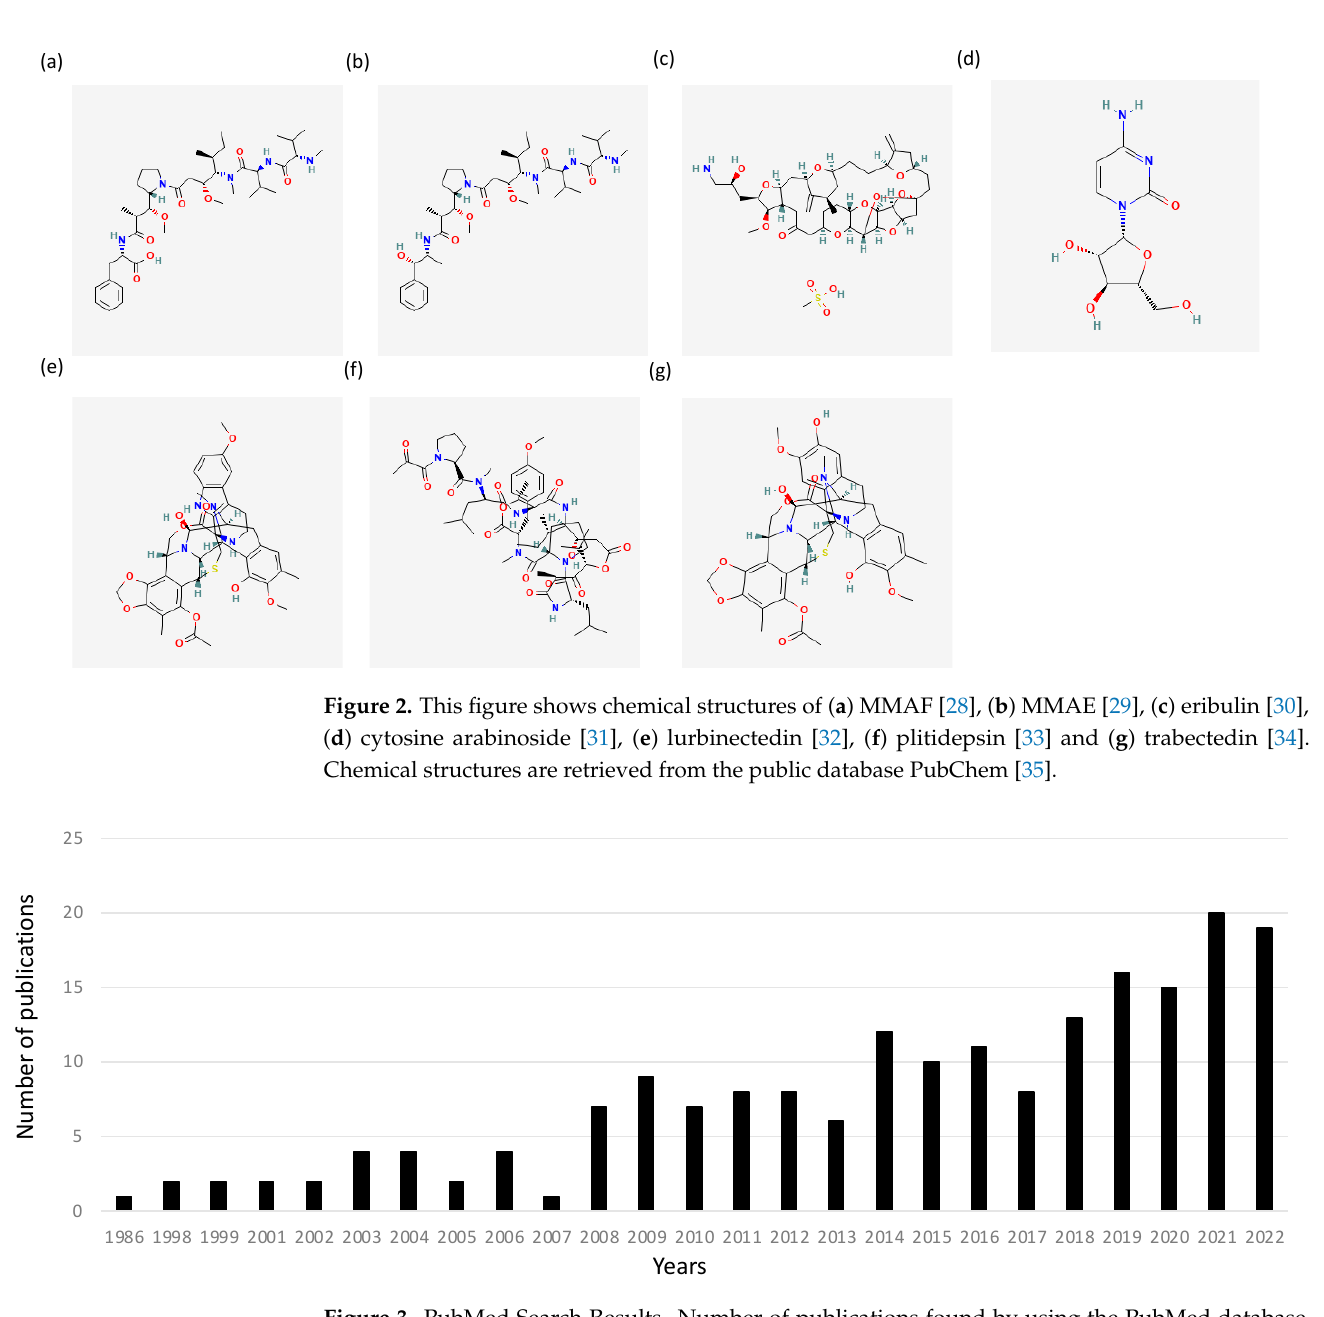
Figure 3. PubMed Search Results. Number of publications found by using the PubMed database search (National Library of Medicine, https://pubmed.ncbi.nlm.nih.gov/; accessed on 3 January 2023) with the keywords “prostate cancer” and “marine